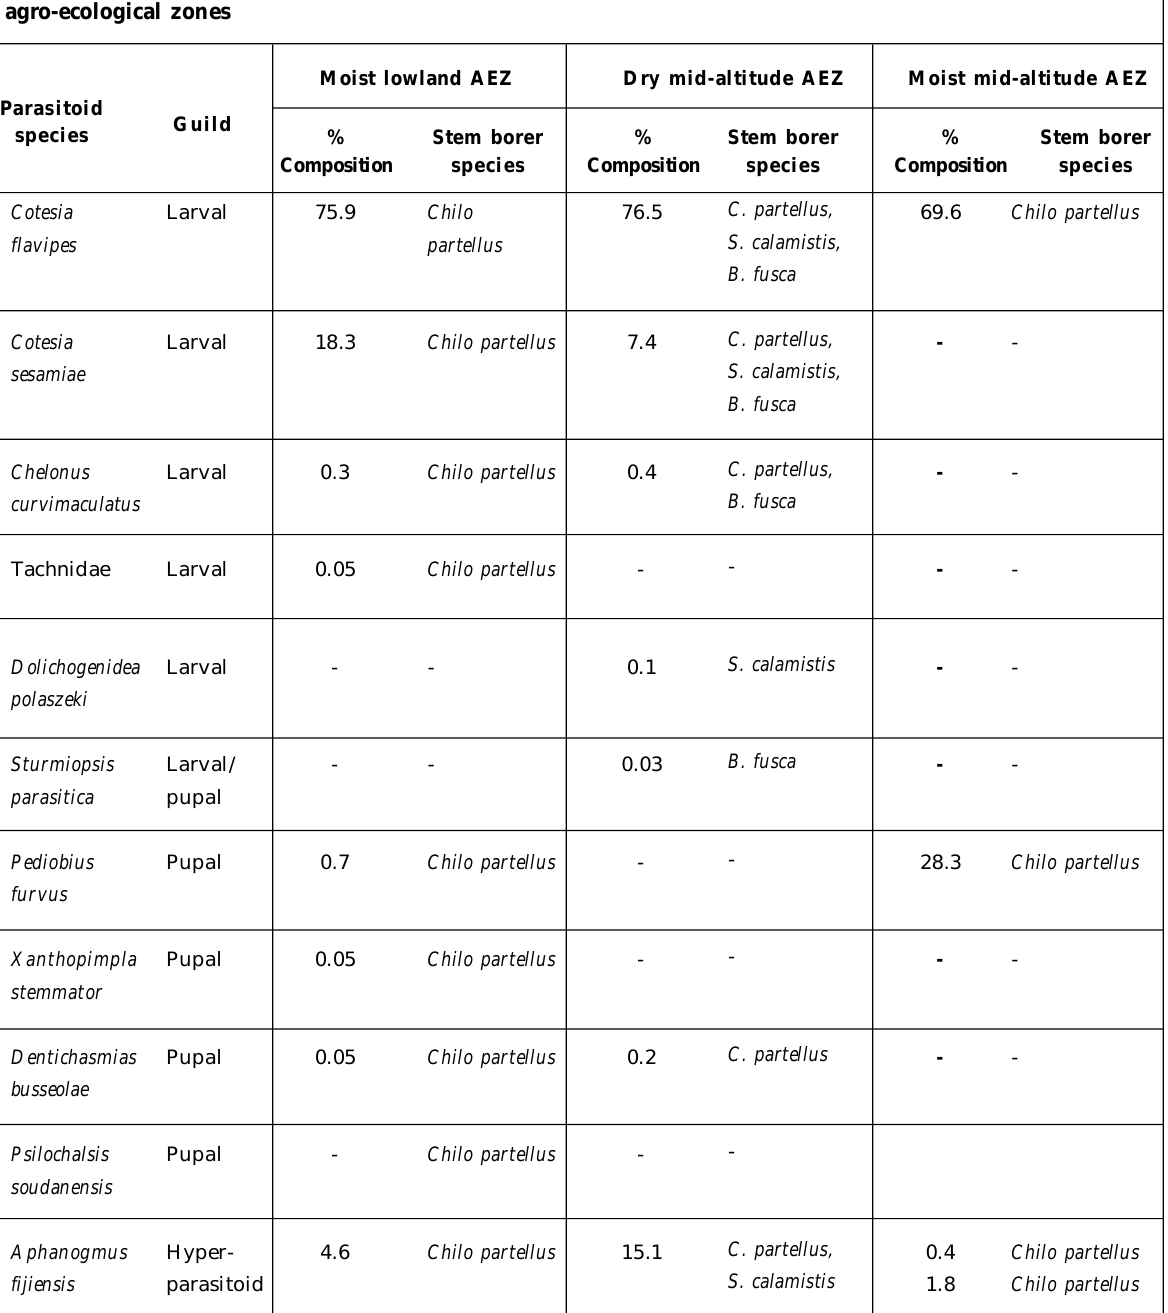
CompositionMoist lowland AEZ Moist mid-altitude Stem borer species% species Composition